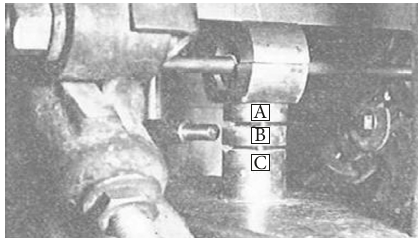
Figure 2: Details of the clamp